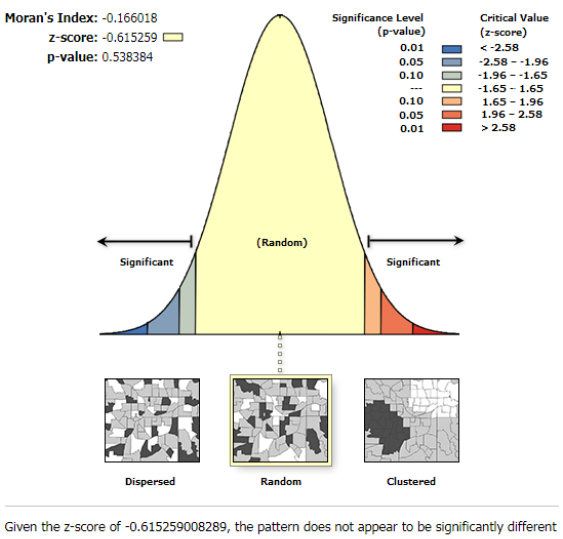
Figure 6. Spatial autocorrelation report for GWR analysis